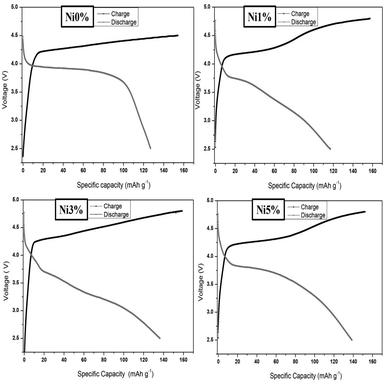
Initial charge and discharge curves of LiMn1-xNixPO4/C cathode materials.